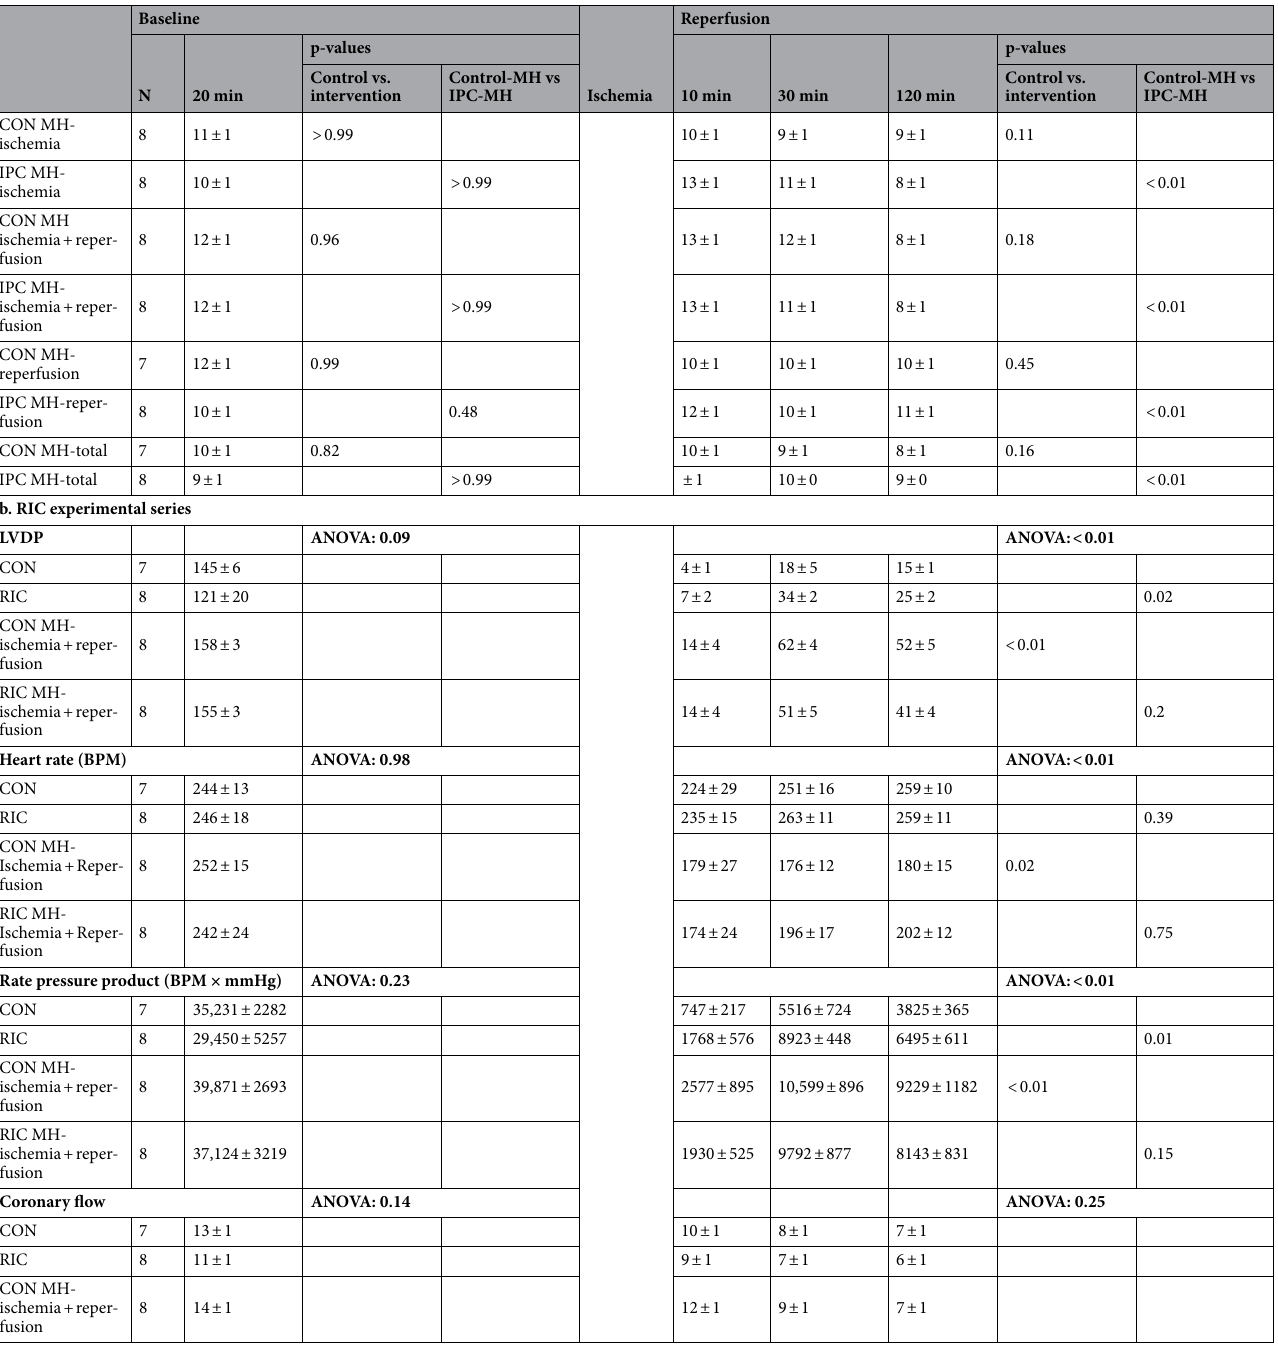
Table 1. Cardiac function. (a) IPC experimental series, (b) RIC experimental series. CON control, IPC ischemic preconditioning, RIC remote ischemic preconditioning, MH-Ischemia mild hypothermia during ischemia, MH-Ischemia + Reperfusion mild hypothermia during half of the ischemia and throughout reperfusion, MH-Reperfusion mild hypothermia during reperfusion, MH-Total mild hypothermia through the total